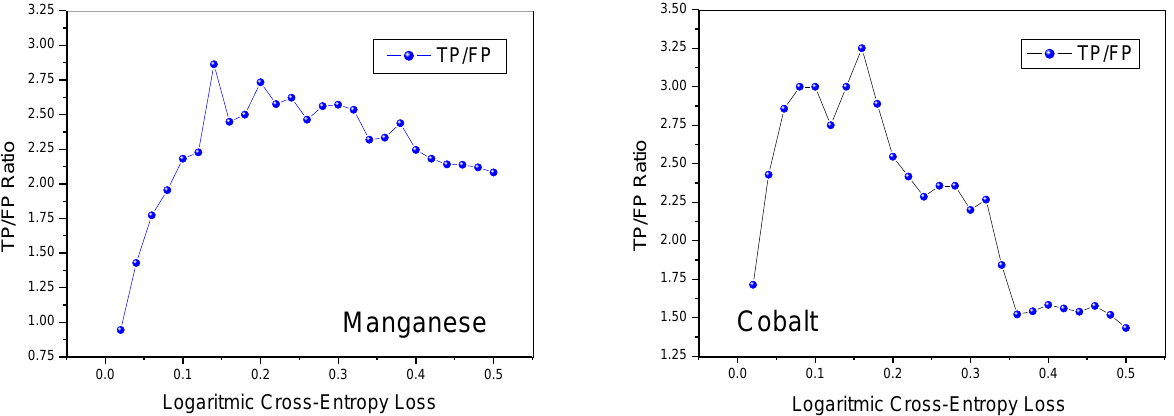
Figure 3. True positives/false positives ratio as a function of the LCEL value for lithiated manganese ( left ) and cobalt ( right ) oxides.